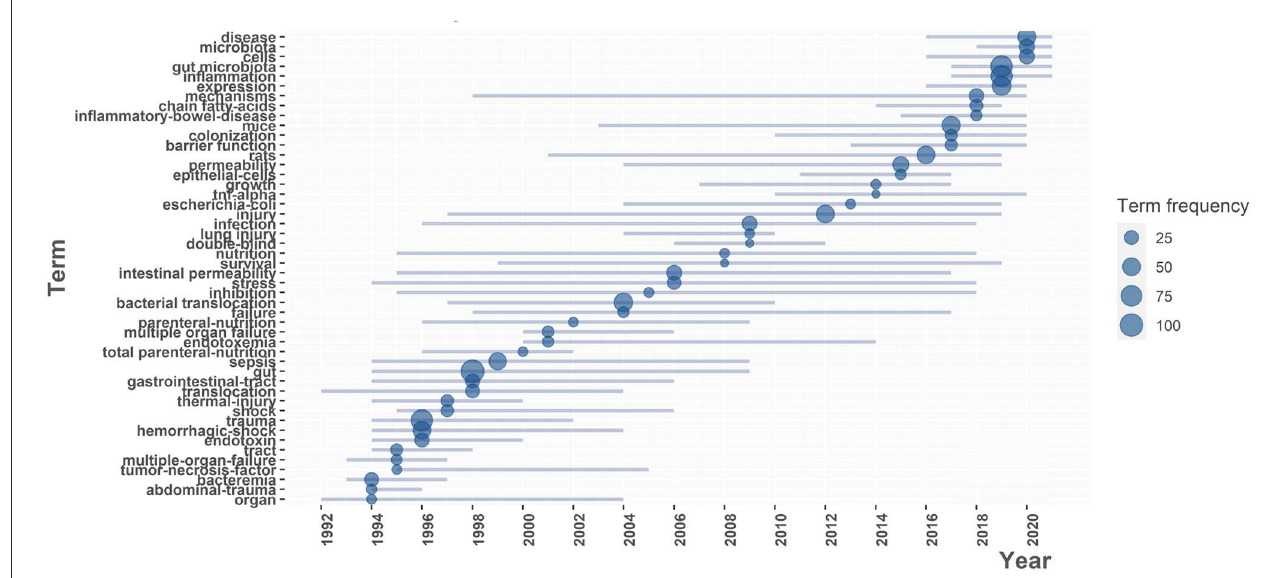
FIGURE9 Trend Topics Analysis with the 3 keywords per year which occurred at least 10 times in the past 3 decades.